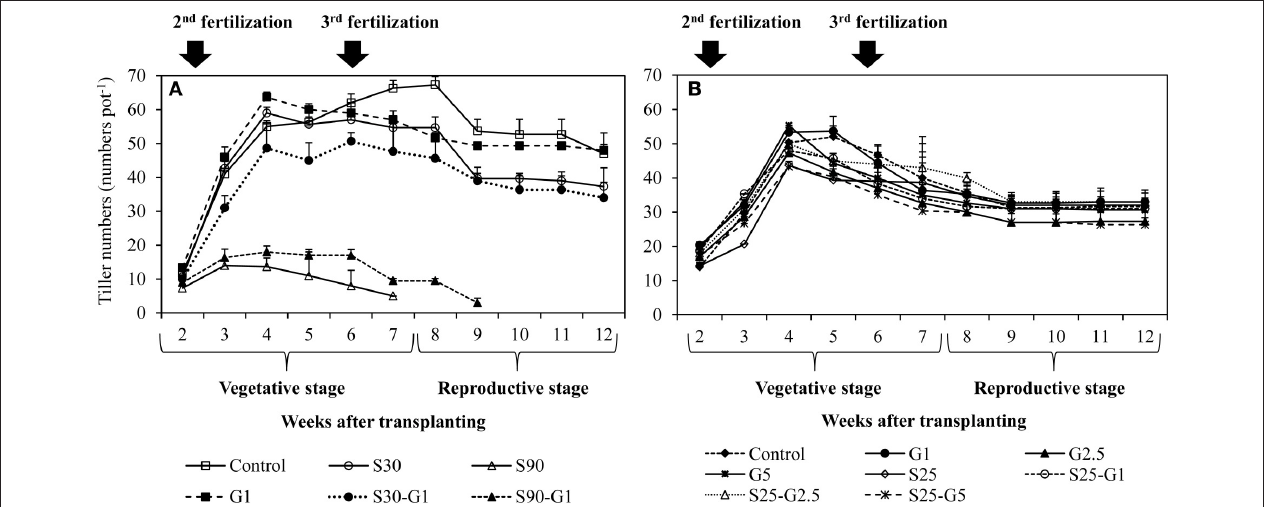
FIGURE 3 | Influence of salinity and gypsum addition upon tillering pattern of rice plants; (A) represents Experiment (I) and (B) represents Experiment (II). Error bars indicate standard deviation.